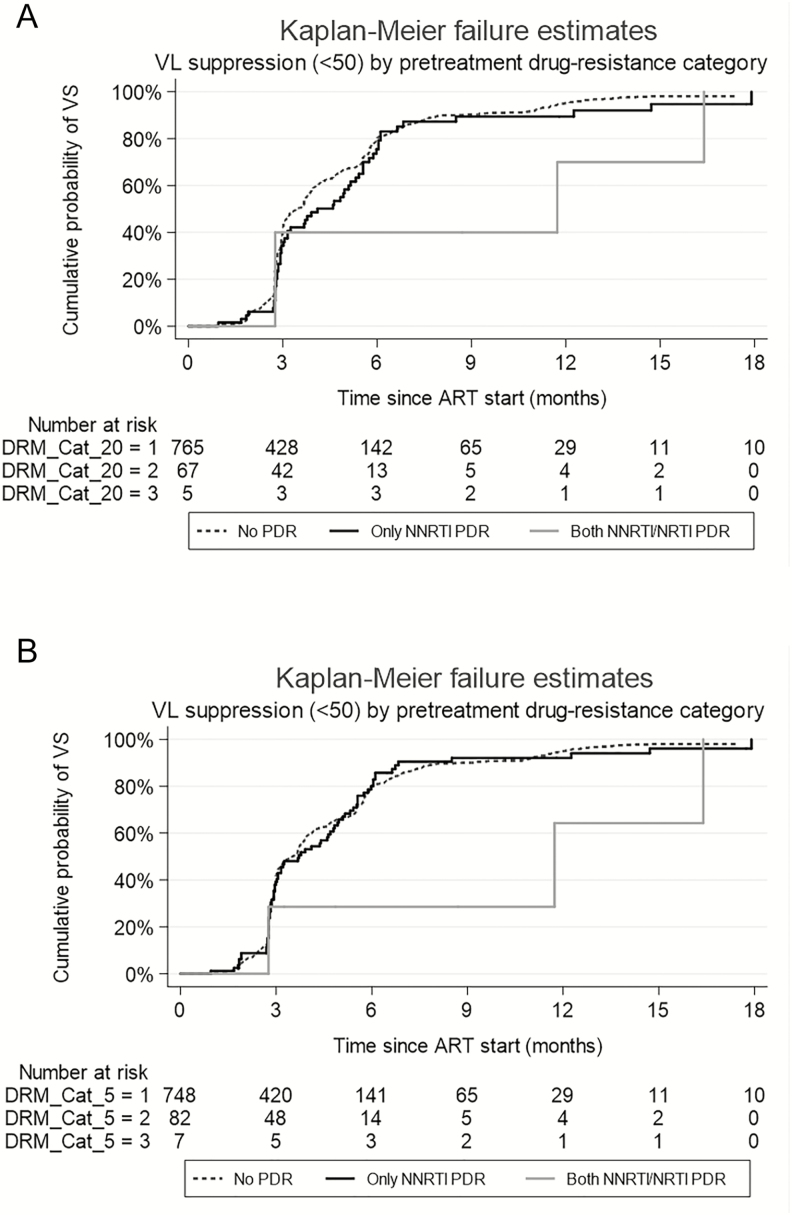
Kaplan-Meier plot of the cumulative probability of virological suppression since antiretroviral therapy start; stratified by class of pretreatment drug resistance at the 20% (A) and 5% (B) detection thresholds. Abbreviations: ART, antiretroviral therapy; DRM, drug-resistance mutation; NRTI, nucleoside reverse transcriptase inhibitor; NNRTI, nonnucleoside reverse transcriptase inhibitor; PDR, pretreatment drug resistance; VL, viral load; VS, virological suppression.